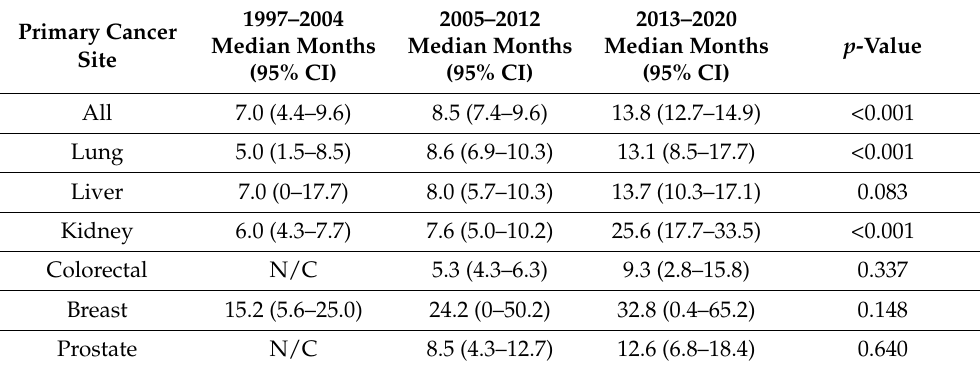
Table 3. Overall survival data according to the top six common primary cancer sites. Table 4. Trends of survival in the top six common primary cancer sites according to the three time frames.